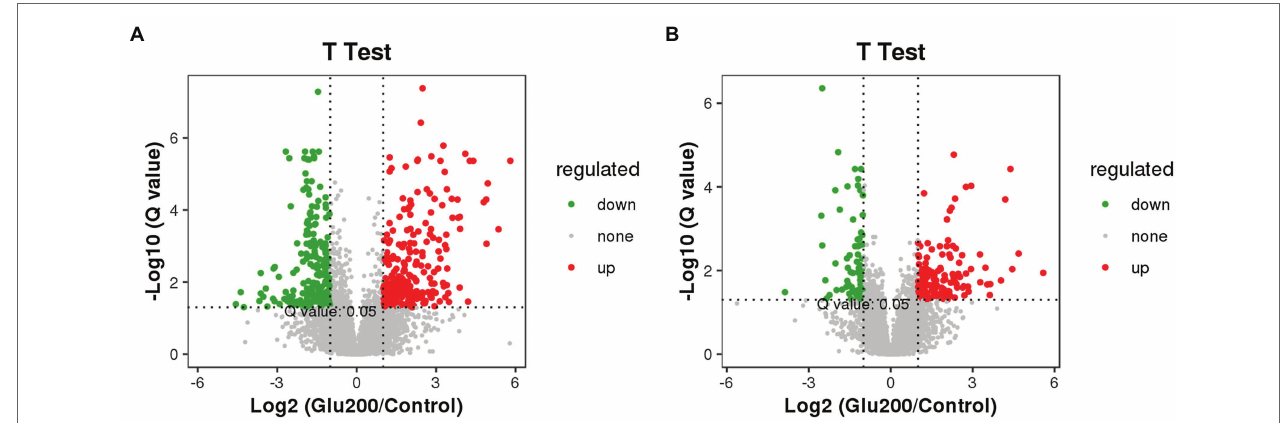
FIGURE 5 | Volcano plot of differential metabolites between the control and the Glu200 groups. The abscissa axis represents the multiple of difference of metabolites (log2), and the vertical axis represents the q -value ( − log10). Each point represents a kind of metabolite; the scatter color represents the final screening result. Significant upregulated metabolites are indicated in red (up), downregulated metabolites are indicated in green (down), and nonsignificant differences in metabolites are gray (none). (A) Represents positive ion modes and (B) represents negative ion